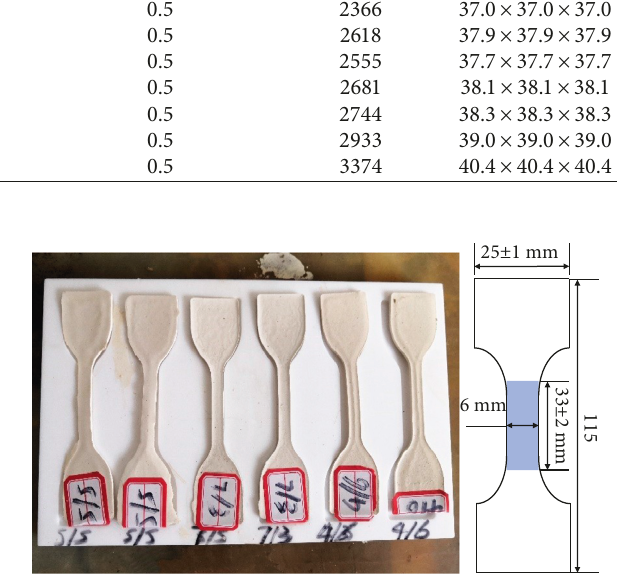
Figure 2: Geometry of tensile sample.